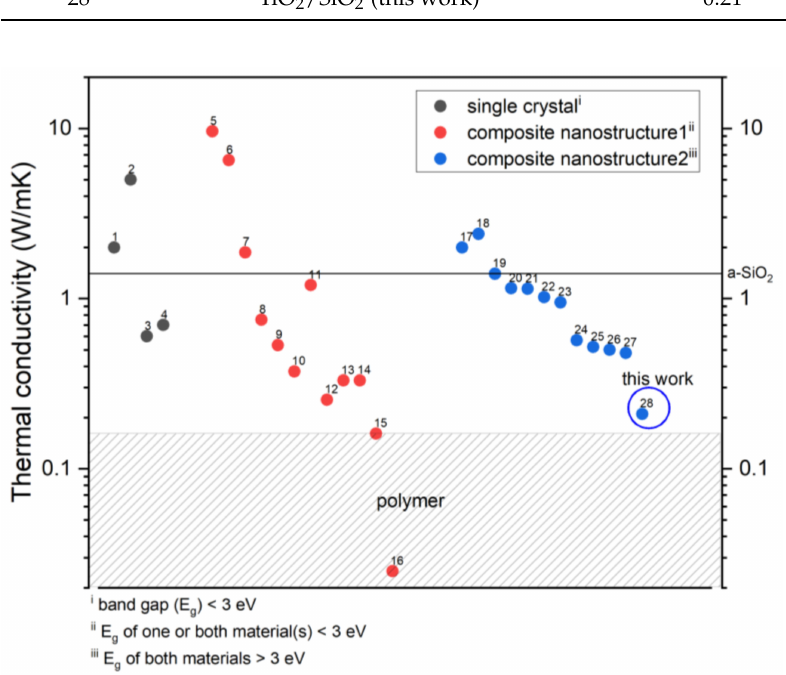
Figure 5. Thermal conductivity at R.T. of the reported inorganic pore-free materials. The label corresponds to the material systems in Table 4. Eg > 3 eV (<3 eV), the material is transparent (nontransparent) to visible light. In this study, TiO 2 /SiO 2 achieved the lowest thermal conductivity compared to the other reported transparent layered